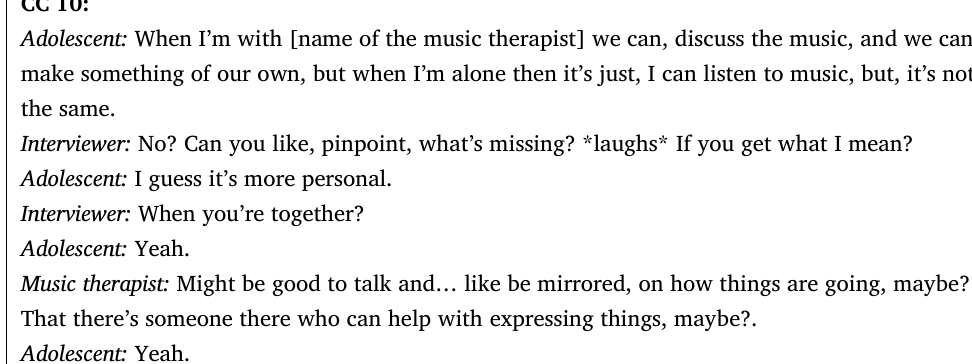
Fuhr and Stensæth. Voices 2022, 22(3).